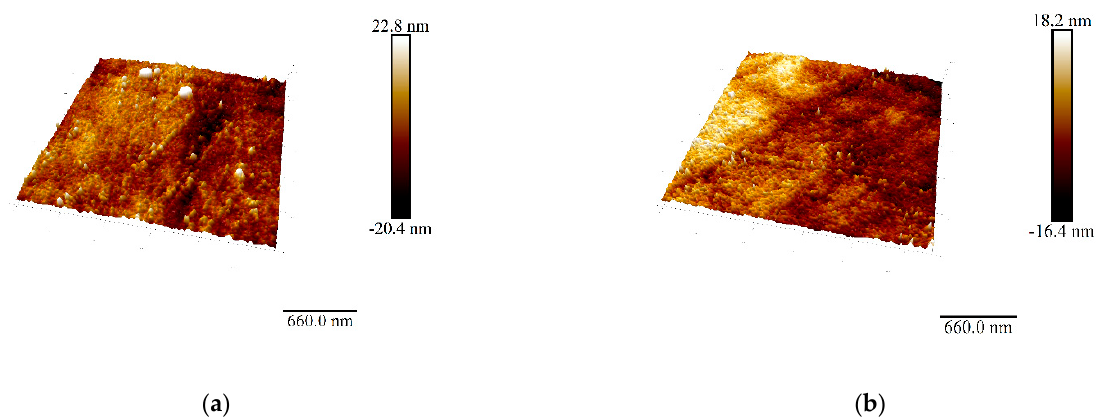
Figure 7. 3D AFM topography of the films on the GCE surface covered with Azure B electropoly- merized from 0.1 M HEPES buffer containing 0.03 M NaCl, pH 7.0 ( a ) in the presence of CHCl 3 ( b ) after 20 cycles of electropolymerization.